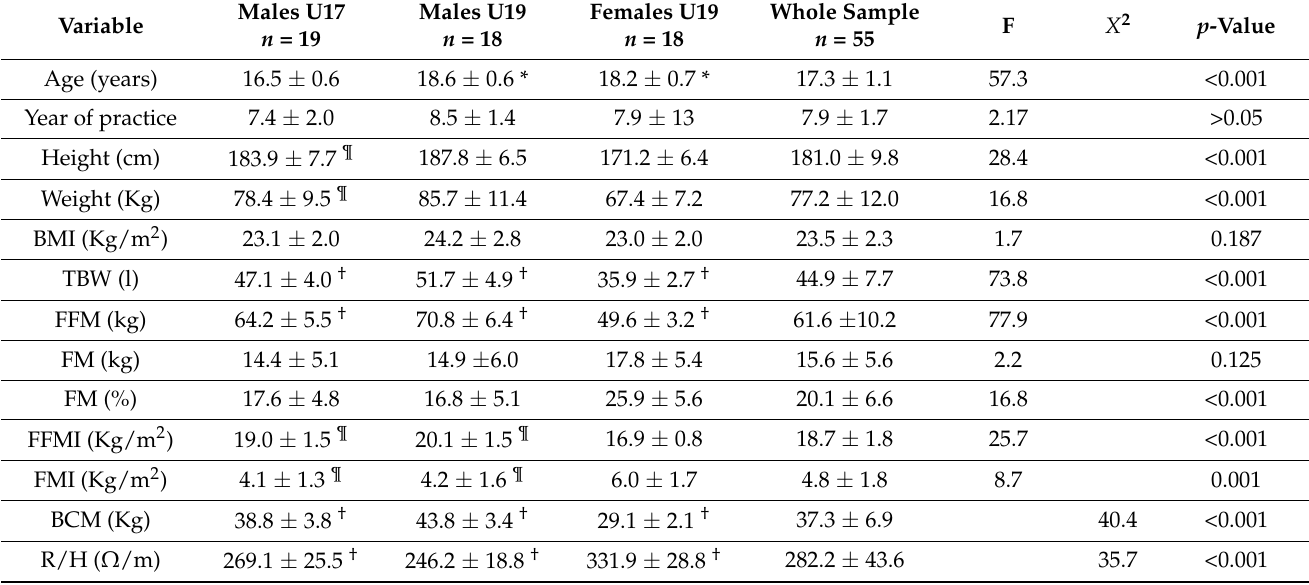
Table 1. Anthropometric, body composition, and bioelectrical data of the whole sample of young male and female elite team handball players and separated by sex and age